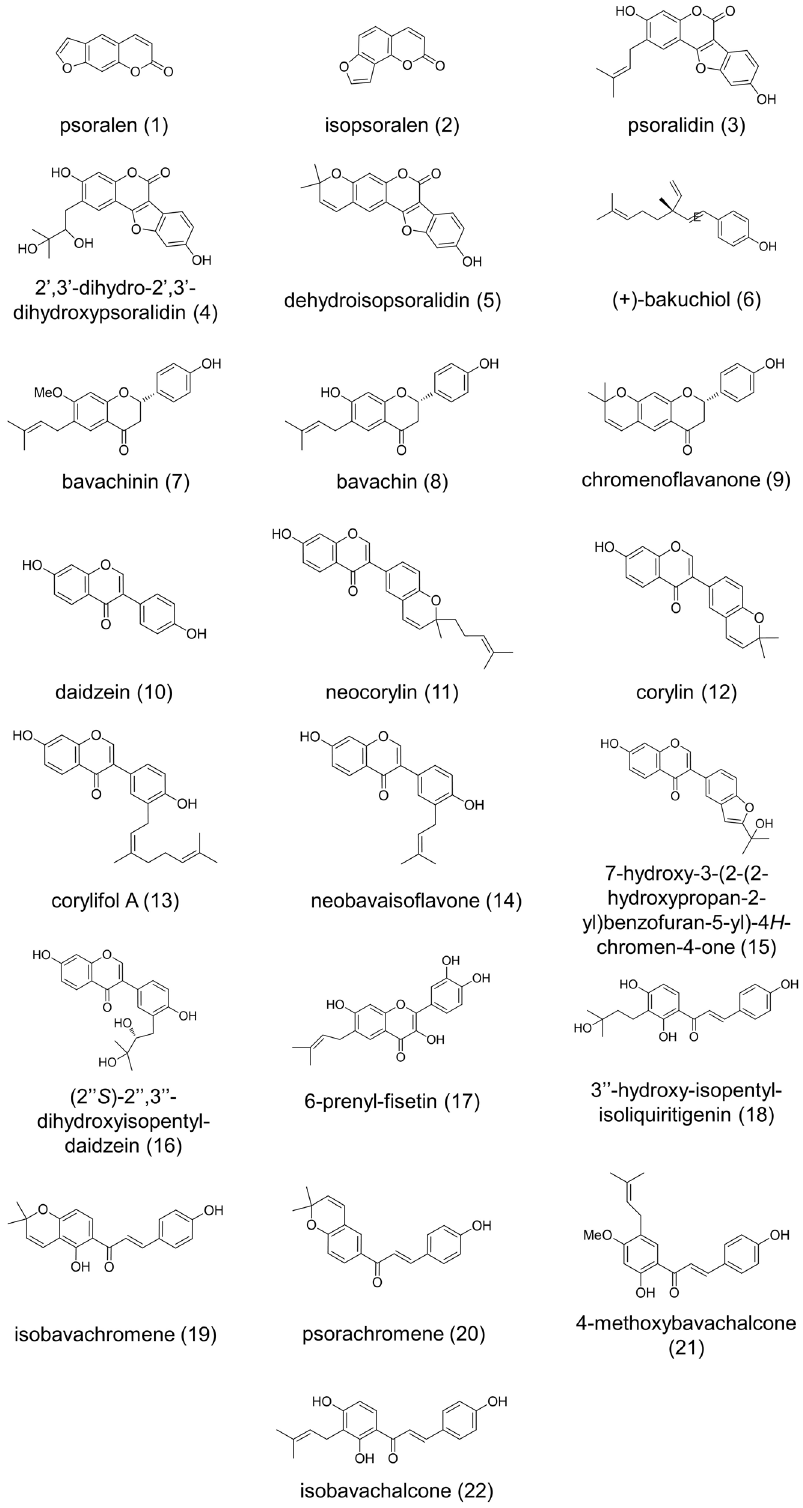
Fig. 2 Pure compounds isolated from the n -hexane extract of Psoralea corylifolia . The compounds were classi fi ed according to their structure: coumarins (1 – 5), benzenoids (6) and fl avonoids (7 – 22). The fl avonoid group was further divided into four subgroups according to their structure: fl avanones (7 – 9), iso fl avones (10 – 16), fl avonol (17) and chalcones (18 – 22). Source data are provided as a Source data fi le.